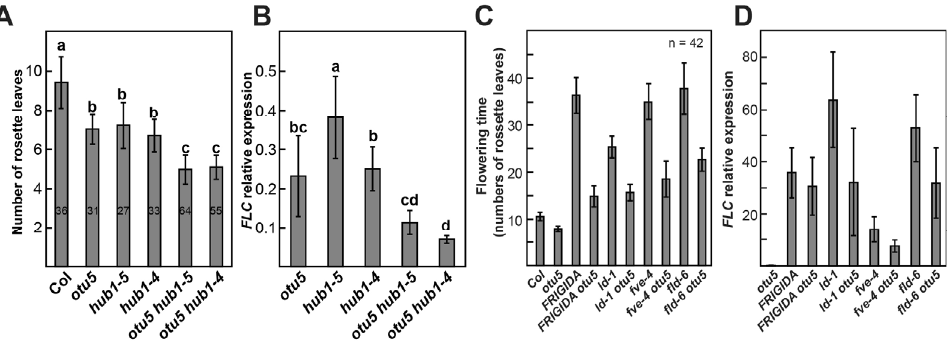
Figure 11. OTU5-mediated flowering suppression is HUB1-independent but partially required for autonomous pathway mutation-mediated FLC upregulation and late flowering. ( A ) Flowering times measured by rosette leaf number at bolting in Col-0 , otu5-1 , hub1-5 , hub1-4 , otu5-1 hub1-5 , and otu5-1 hub1-4 plants grown under long-day conditions; sample sizes (27–64) were indicated. ( B ) Relative FLC expression levels examined by RT-qPCR. ( C ) Flowering times measured by rosette leaf number at bolting under long-day conditions in Col-0 , otu5-1 , Col-0 - FRIGIDA , various autonomous pathway mutants ( ld-1 , fve-4 , and fld-6 ), and otu5-1 crossed-in double mutants: Col-0 - FRIGIDA otu5-1 , ld-1 otu5-1 , fve-4 otu5-1 , and fld-6 otu5-1 . ( D ) Relative FLC expression levels examined by RT-qPCR. The averaged relative FLC expression levels were determined from three biological repeats. Different letters denote significant differences by pairwise comparison using Student’s t -test. Error bars indicate standard deviations; n represents the sample size.